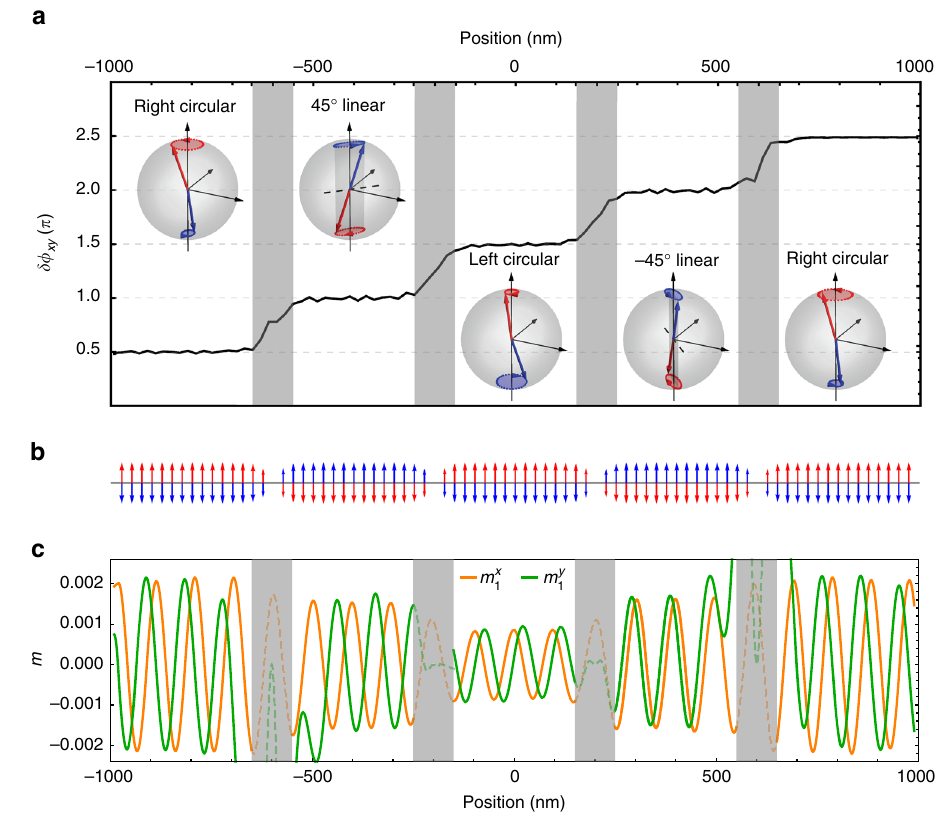
Fig. 4 Micromagnetic simulation of a series of spin wave retarders. At working frequency ω /2 π = ω 2 /2 π = 16.2 GHz, each domain wall is a quarter-wave plate. The right-circular spin waves are injected from the left side. a The relative phase accumulation δϕ xy between the x -polarization and y -polarization components as function of position when the spin wave passes through four domain walls. The time traces of magnetization on a Bloch sphere in each domain (amplitudes exaggerated by 150 times) are shown in the insets. b The static domain wall pro fi le m z m x and m y at a given time, showing that the relative phase changes from domain to domain. In this simulation, we arti fi cially set the damping coef fi cient to 1 1 be zero to show that the retarder (domain wall) itself is (nearly) re fl ectionless and does not in fl uence the amplitude of spin